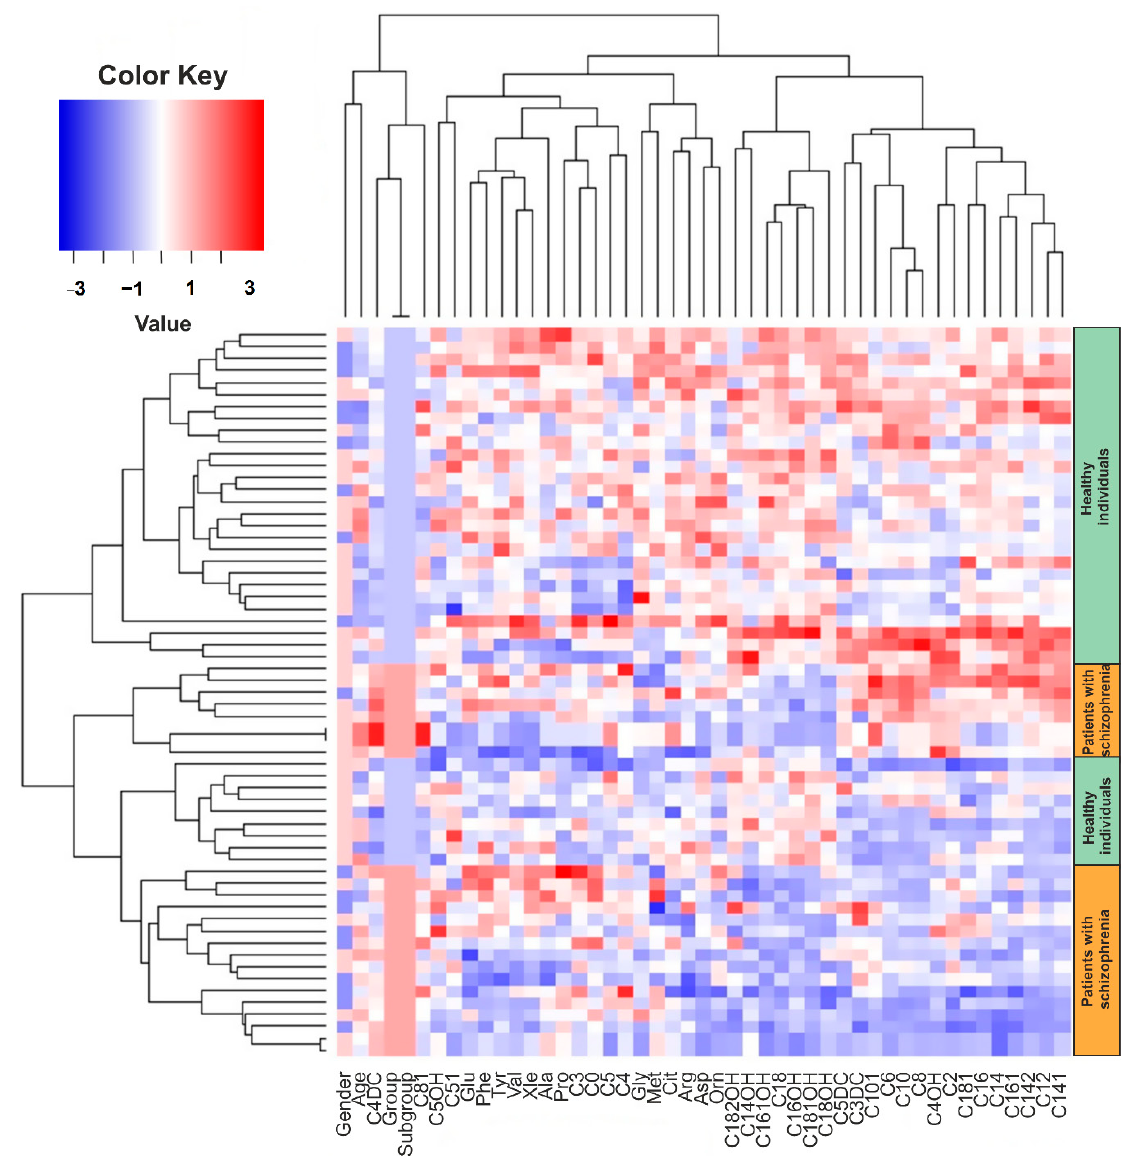
Figure 1. Hierarchical analysis of the amino acids and acylcarnitine changes dataset. The rows represent the patients ′ samples and the columns represent the analyzed parameters (amino acids, acylcarnitine, groups, age). In the heatmap, the color codes a dimensional scale, where the blue gradient corresponds to the decrease of values and red gradient corre- sponds to increase of values in the patient group in comparison to healthy control group.